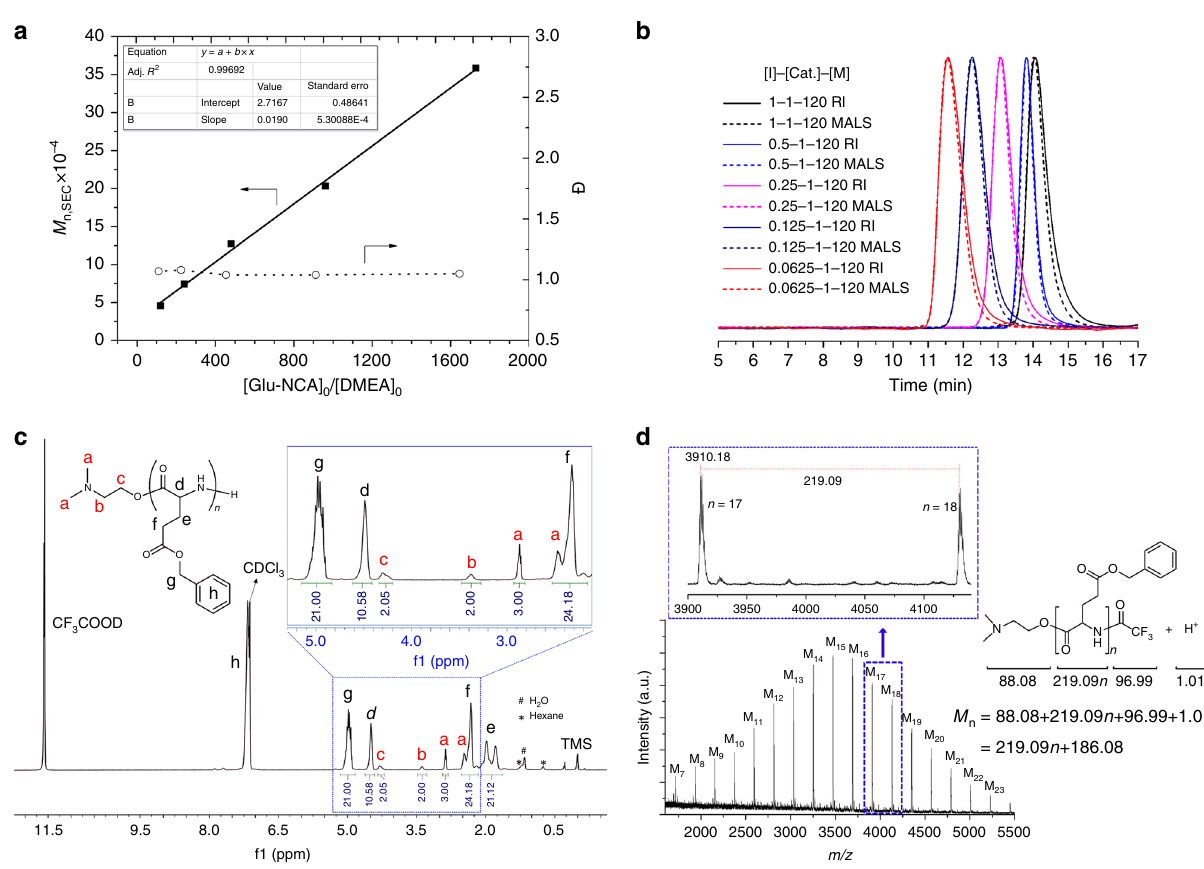
Fig. 3 Characterization of polypeptides synthesized from ROP of Glu-NCA initiated by DMEA in the presence of 1,3-Bis-HFAB catalyst. a plots of [Glu- NCA] 0 /[DMEA] 0 vs M n,SEC and [Glu-NCA] 0 /[DMEA] 0 vs Đ ; b SEC traces of obtained polypeptides (Table 1, runs 1 – 5, solid and dash lines represents RI and MALS responses, respectively); c 1 H NMR spectrum of PBLG 10 (500 M, 25 °C, CDCl 3 /CF 3 COOD = 2, the M n,calcd is 2192 and the M n , NMR calculated based on the integral ratio of H g /H b is 2302; d MALDI-TOF MS spectrum of PBLG 15 (the chain-end was capped with tri fl uoroacetyl group by using tri fl uoroacetic anhydride). (Source data are provided as a Source Data fi